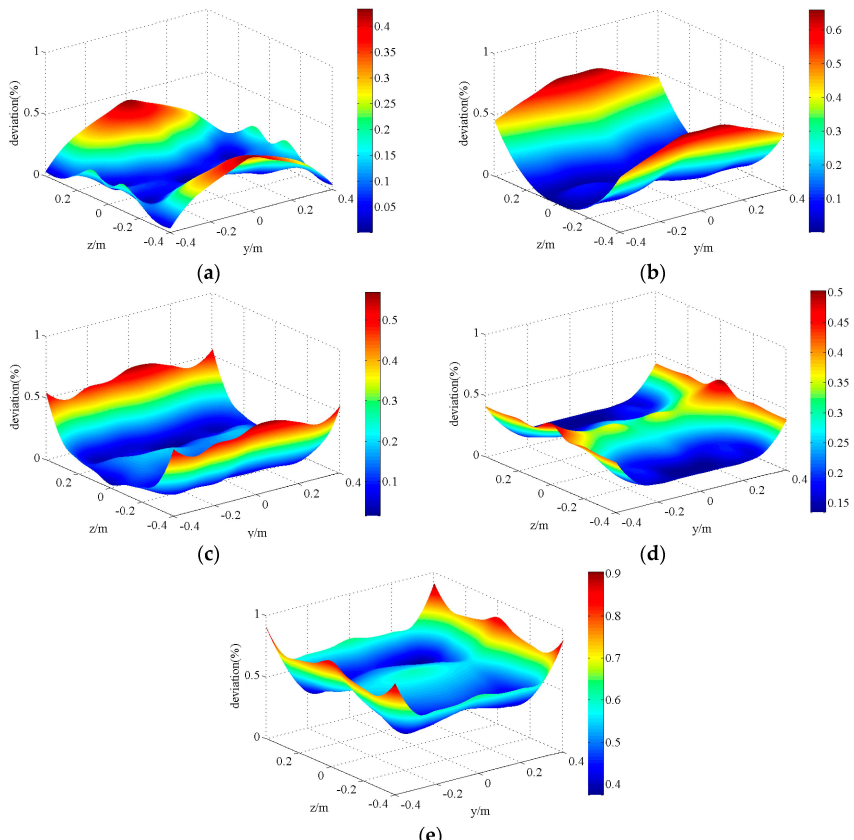
Figure 12. Practical deviation rate ∆ B pr of the generated magnetic flux density of the new coil: ( a ) in the plane of x = 0 m; ( b ) in the plane of x = − 0.1 m; ( c ) in the plane of x = − 0.2 m; ( d ) in the plane of x = − 0.3 m; and, ( e ) in the plane of x = − 0.4